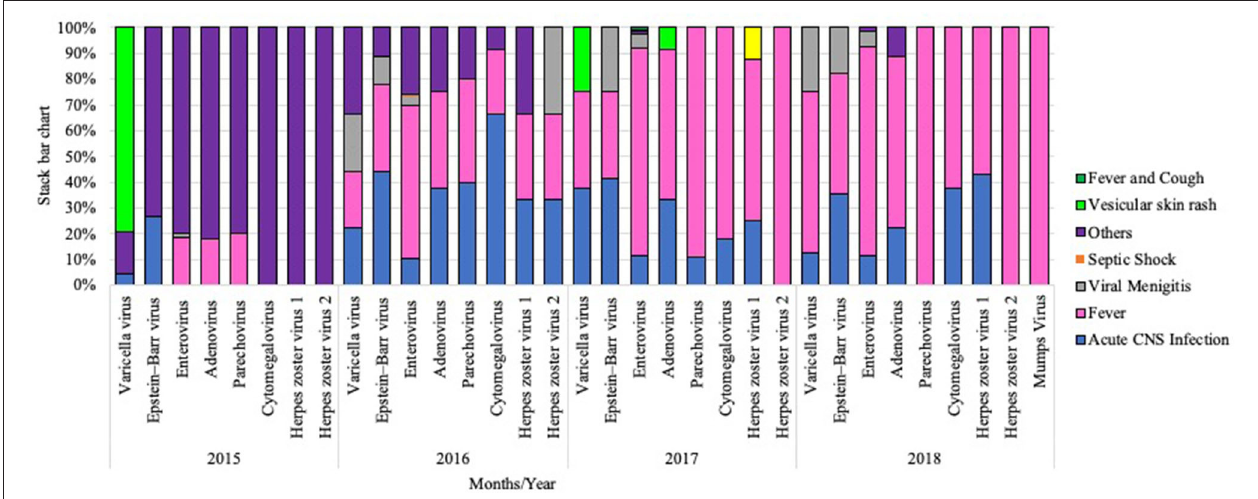
FIGURE 4 | Stacked bar chart representing clinical manifestations among each VM cases during the study period from 2015 to 2018.